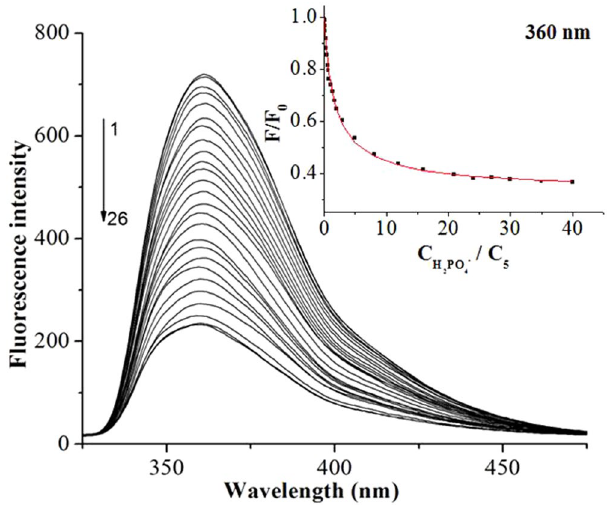
Figure 10. Fluorescence titration spectra of 5 (1.0 × 10 − 5 mol/L) in the presence of different concentrations of H 2 PO 4 − in CH 3 CN at 25 °C. C H2PO4 − for curves 1–26 (from top to bottom) are 0, 0.01, 0.07, 0.11, 0.17, 0.25, 0.33, 0.43, 0.55, 0.67, 0.8, 1, 1.35, 1.75, 2, 3, 5, 8, 12, 16, 21, 24, 27, 30, 35, 40 × 10 − 5 mol/L ( λ ex = 280 nm). Inset: the fluorescence at 360 nm of 5 as a function of H 2 PO 4 −